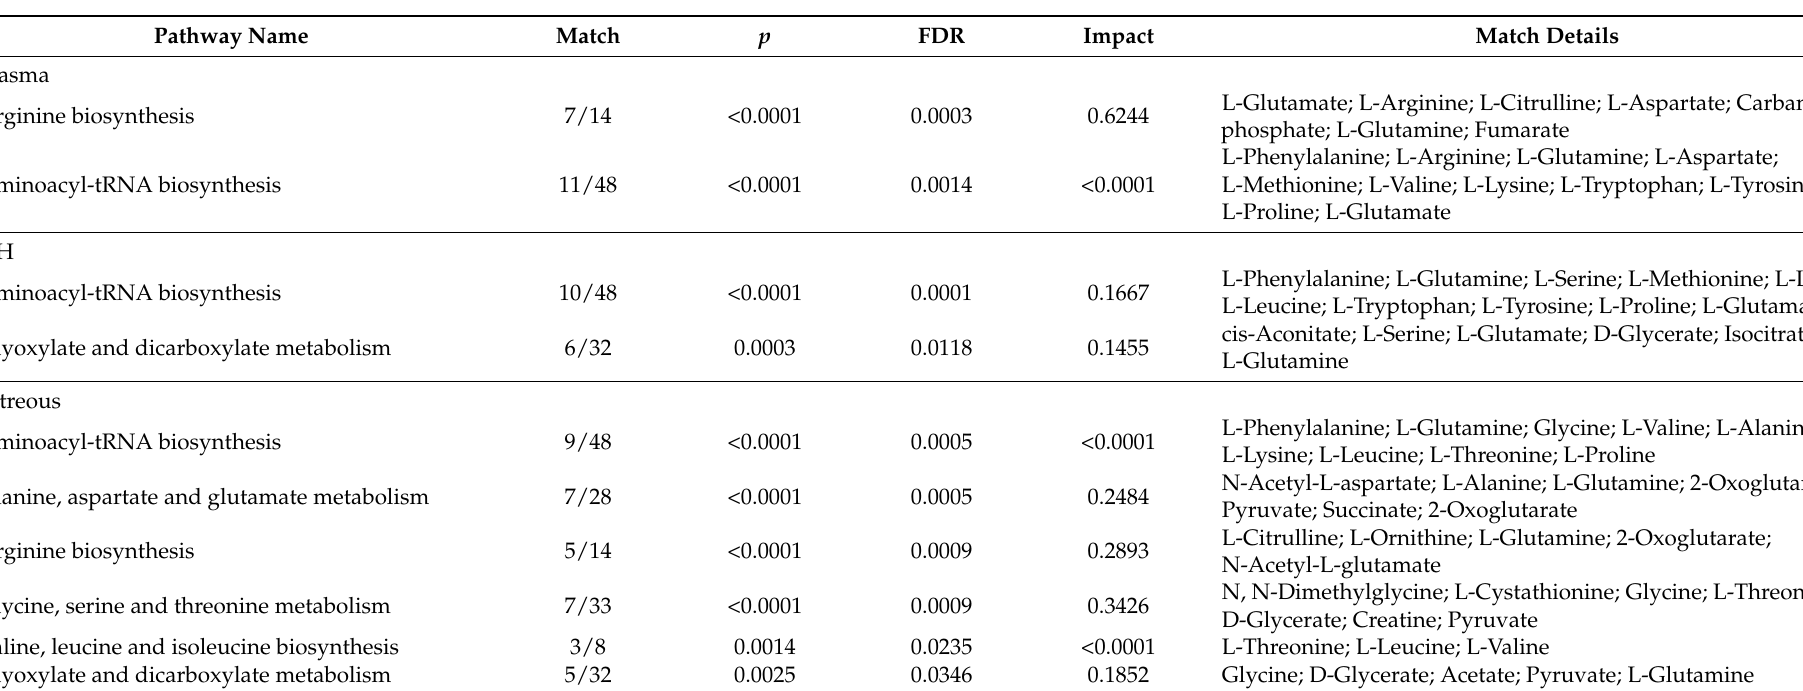
Table 2. Results of the Pathway Analysis of Metabolic Biomarkers.